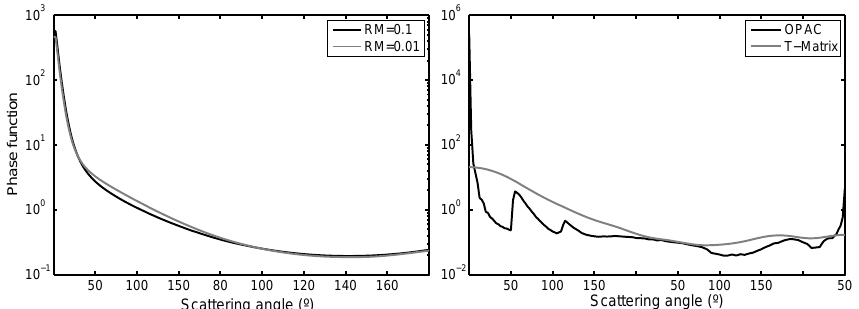
Figure 9. (a) Phase functions at 370nm calculated by the empirical formulation proposed by Pollack and Cuzzi assuming a bimodal size distribution. The phase functions are calculated for two different ratios between modes. (b) Phase functions at 902nm derived from the OPAC software and T-matrix method for cloud